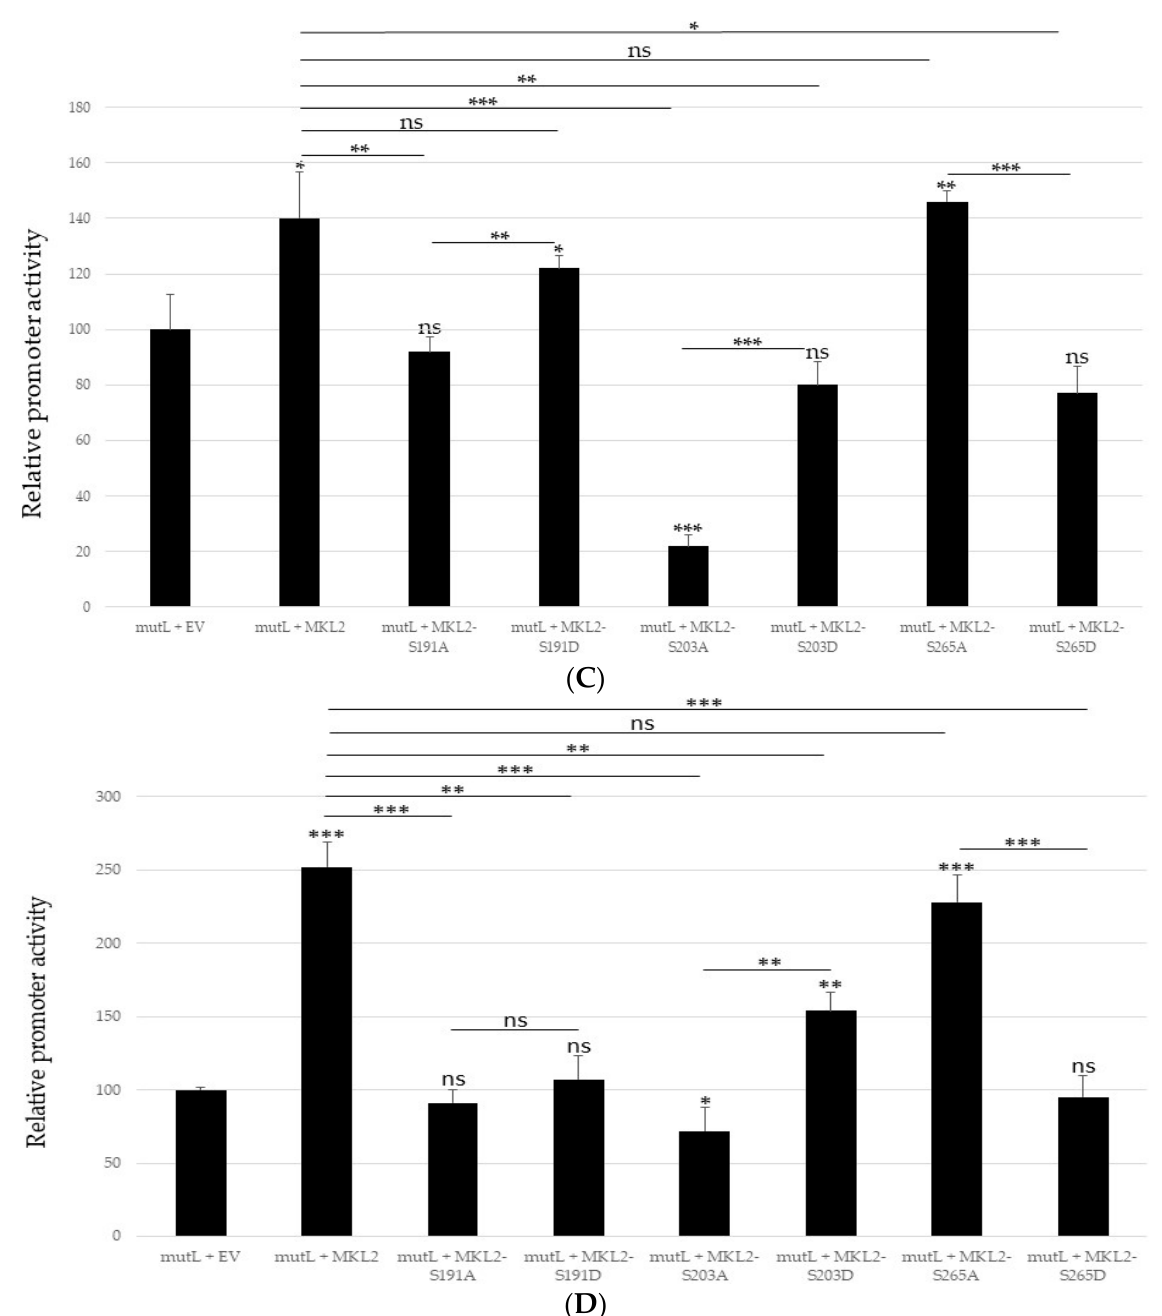
Figure 6. Single substitutions in PKA phosphoacceptor residues alter MKL2 LTag’s effect on MCPyV early and late promoter. Cells were co-transfected with luciferase reporter plasmid containing the replication deficient early ( A , B ) or late promoter ( C , D ), and 100 ng ( A , C ) or 400 ng ( B , D ) empty vector (EV), or expression plasmid for MKL2 LTag or single mutants in the residues S191, S203, and S265, respectively. Statistically significant differences with empty expression vector are indicated on top of the bar, whereas differences between MKL2 LTag and the mutants and between the A and D mutants are indicated on top of the horizontal lines (* p < 0.05; ** p < 0.01; and *** p < 0.001; ns = not significant). Luciferase values were corrected for protein concentration of the sample, and the corrected value for the empty vector was arbitrarily set as 100%.